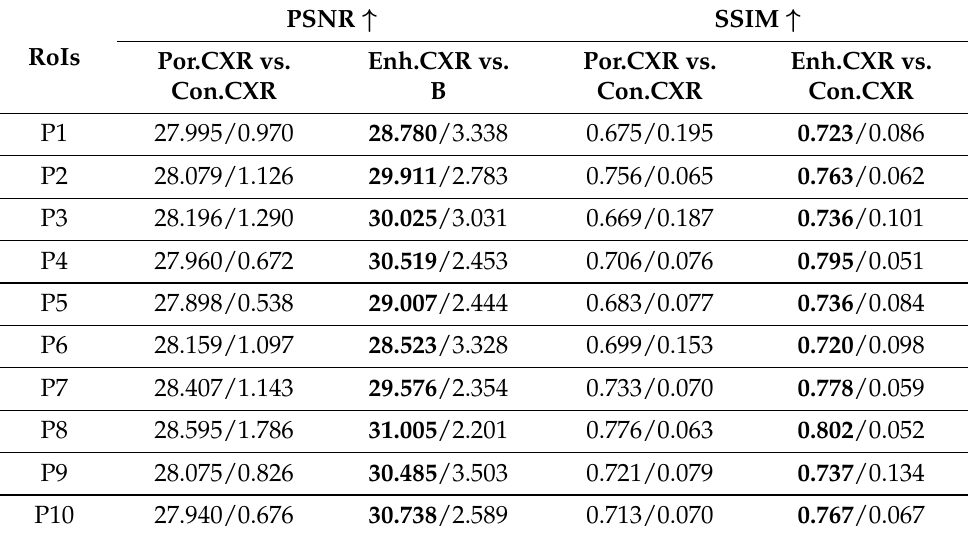
Table 3. Mean/std of PSNR and SSIM on the areas surrounding landmark points between the portable CXR (Por.CXR) and conventional CXR (Con.CXR) and between the enhanced CXR (Enh.CXR) and conventional CXR